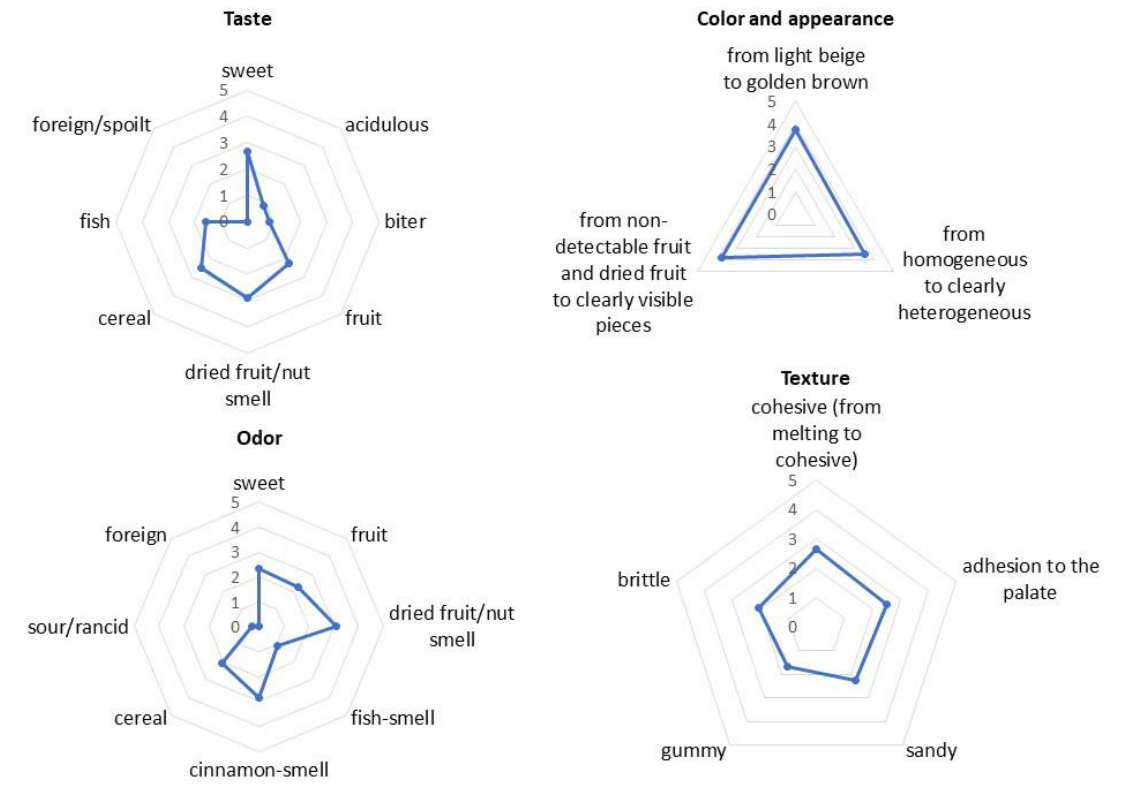
Figure 2. Sensory evaluation of innovative snacks via profiling analysis.